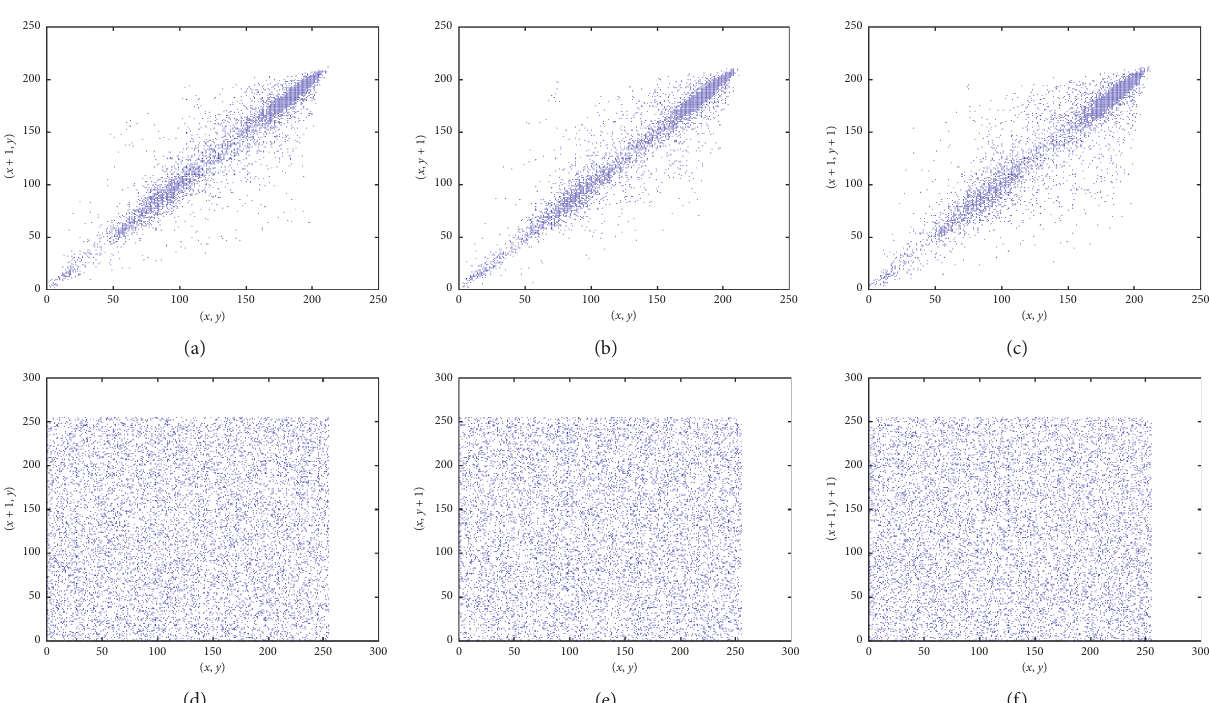
Figure 5: The correlation between X-X, Y-Y, and X-Y directions of the plain image and the cipher image.